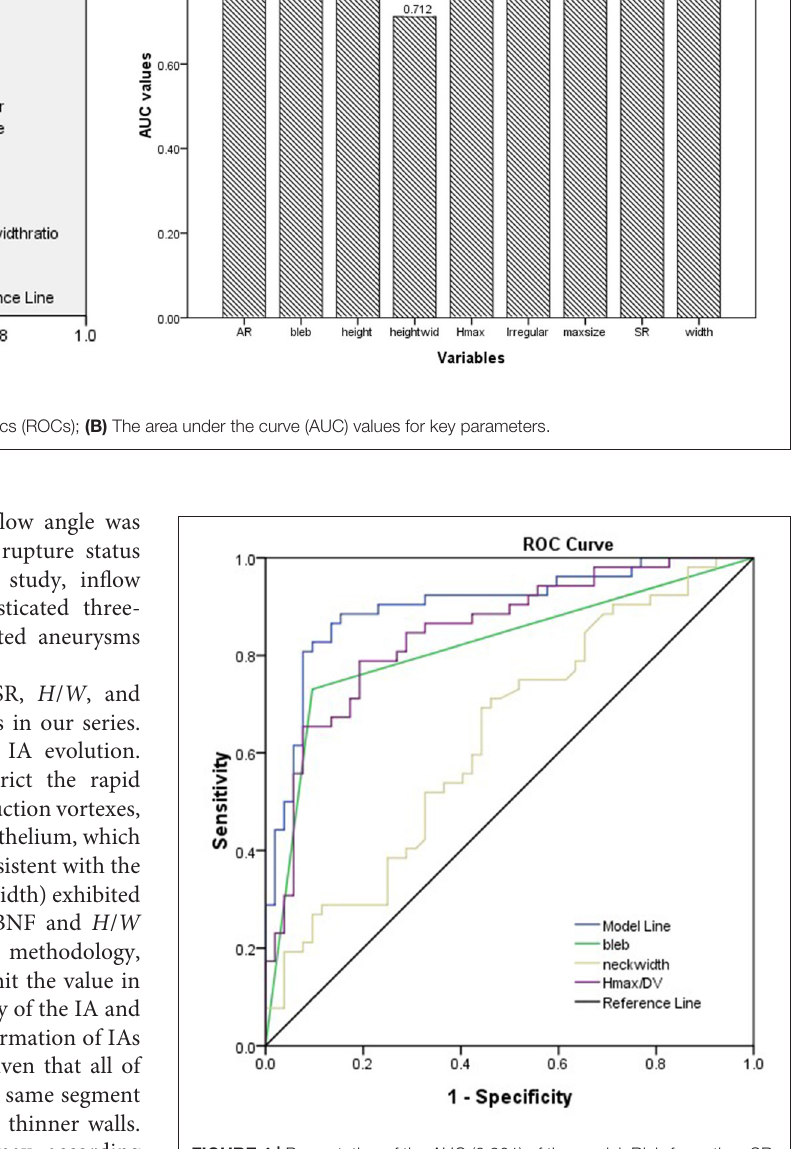
FIGURE 4 | Presentation of the AUC (0.901) of the model. Bleb formation, SR, and neck width were the parameters leading to the prediction quality of models with respect to rupture status of the